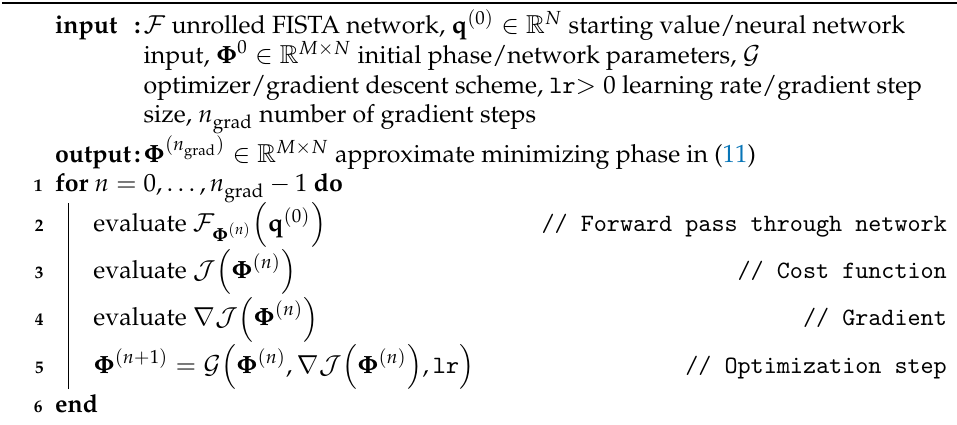
Algorithm 2: Gradient descent minimization scheme for the solution of